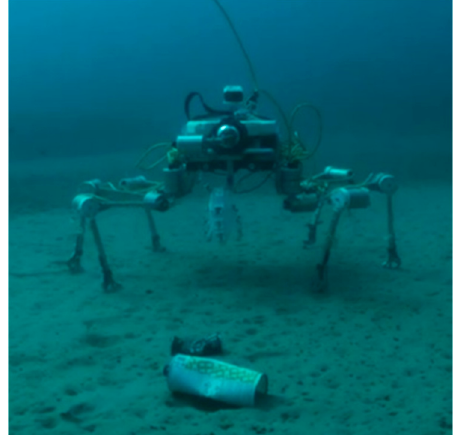
Figure 1. The Underwater Legged Robot (ULR) SILVER2 equipping the cable-driven gripper presented in this work. Table 1. Requirements for the development of the soft gripper resulting from interviews with the team of developers, a marine scientist, and a mission operator/ROV pilot. Five prototypes in the state-of-the-art [9,10,12,13,21] have been evaluated against the requirements collected, and the Ocean One hand [12] obtained the highest score.